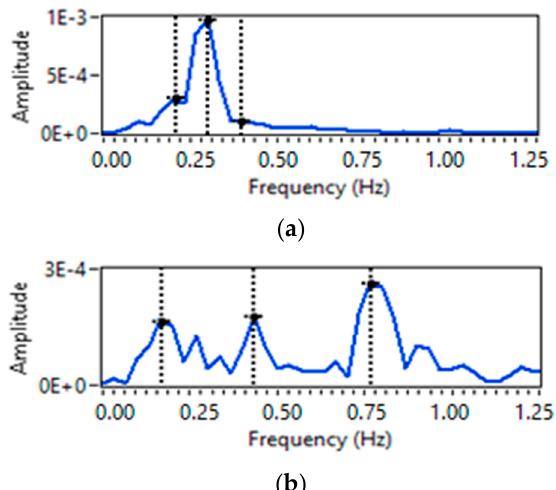
Figure 11. Breathing rate extraction for three persons-scenario: ( a ) normal–normal–normal; and ( b ) normal-slow-fast. ( b )